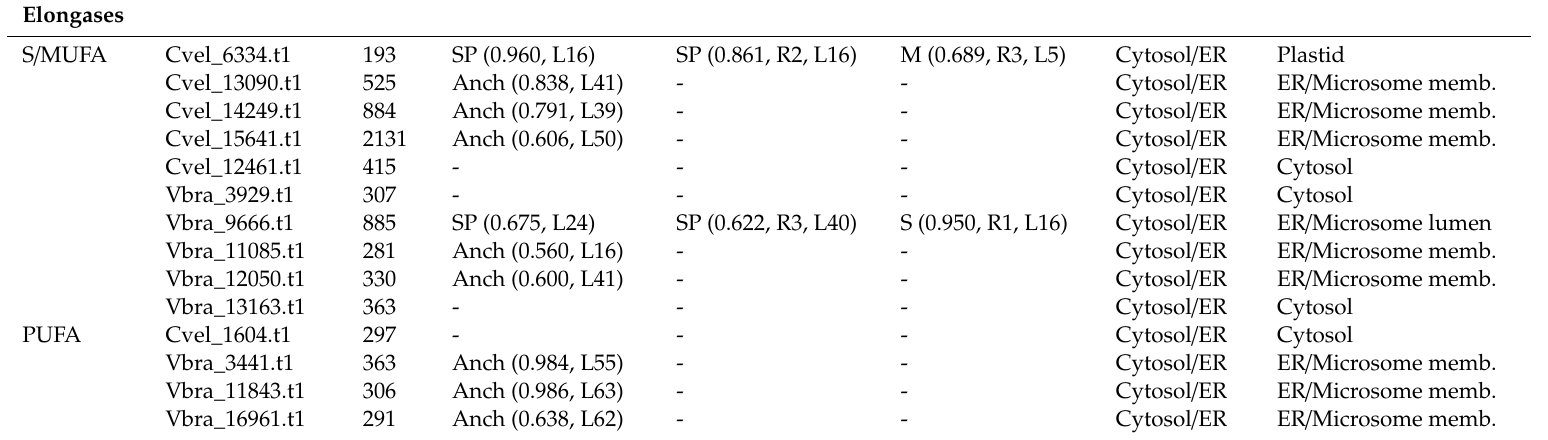
Table 4. Ketoacyl synthases, elongases, and desaturases in chromerids and their predicted subcellular location. S / MUFAs, saturated and monounsaturated FAs, PUFA, poly-unsaturated